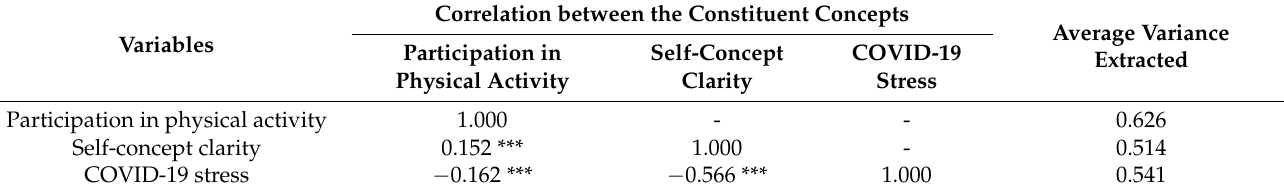
Table 4. Verification of discriminant validity.